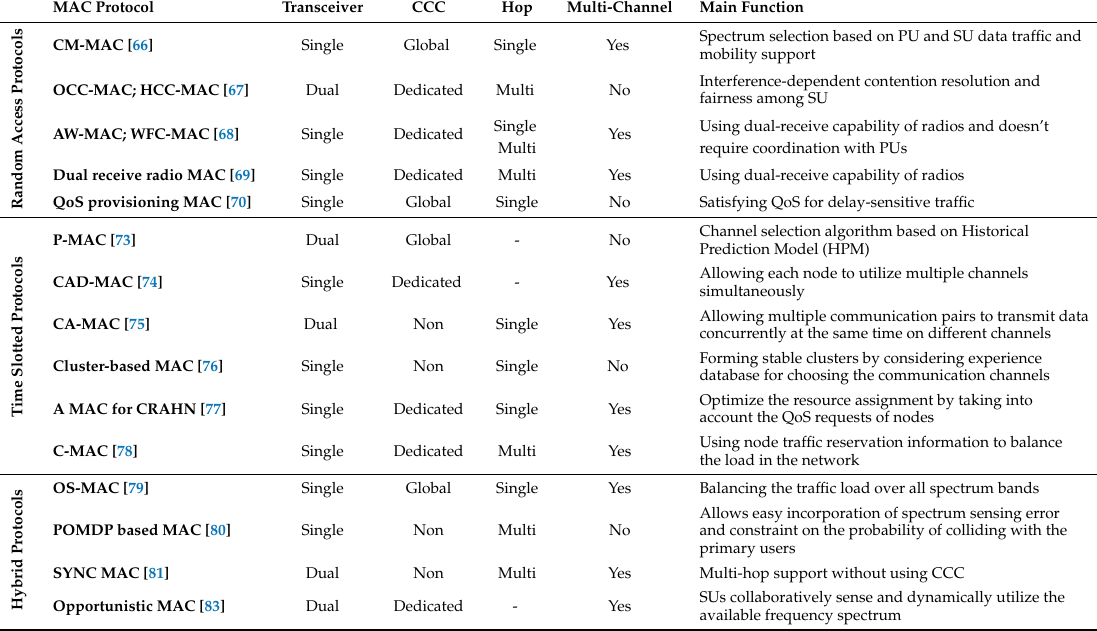
Table 1. CRAHN MAC protocol comparison